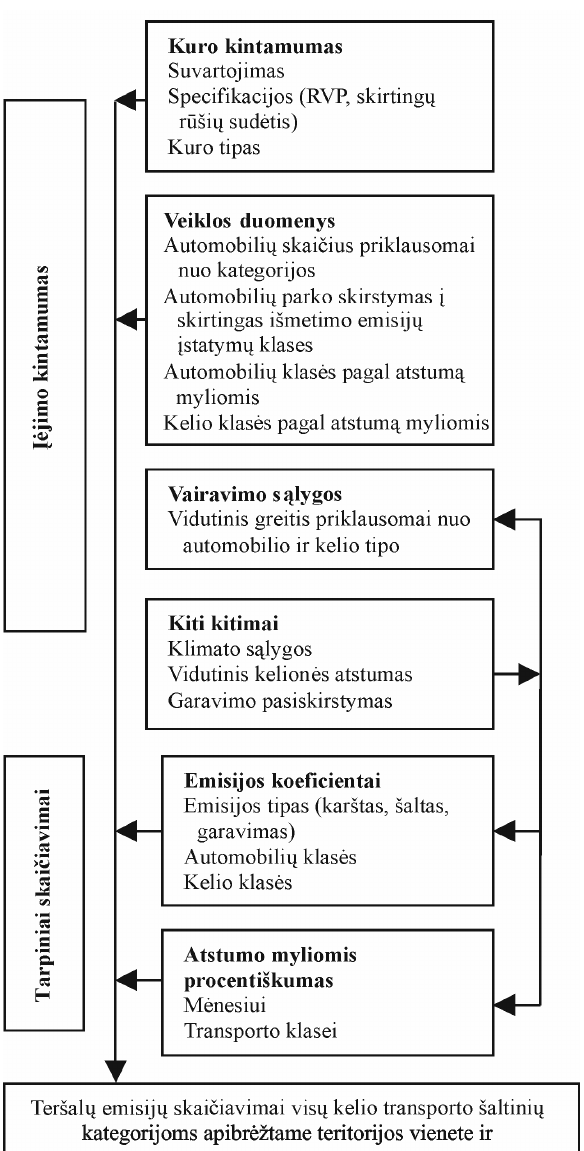
Fig. 1. Block-scheme of metodology